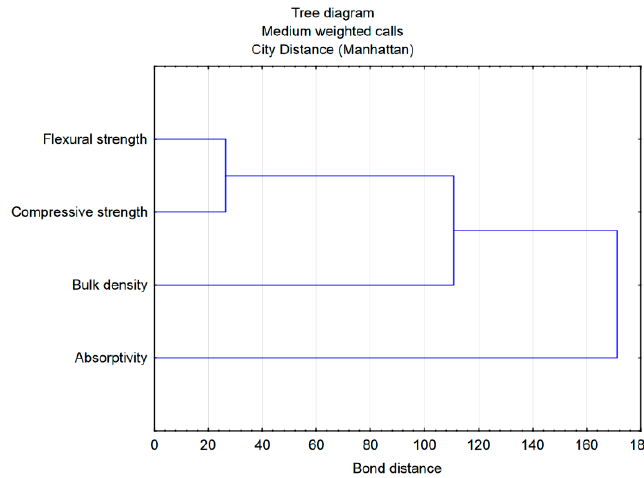
Figure 12. Dendrogram obtained for the properties tested of mortars.